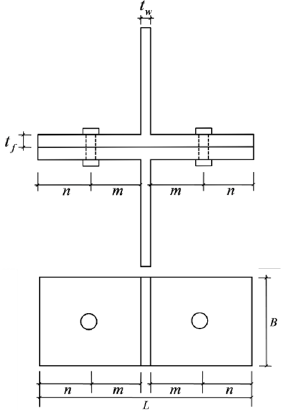
Figure 4. Schematic diagram of the T-stub.